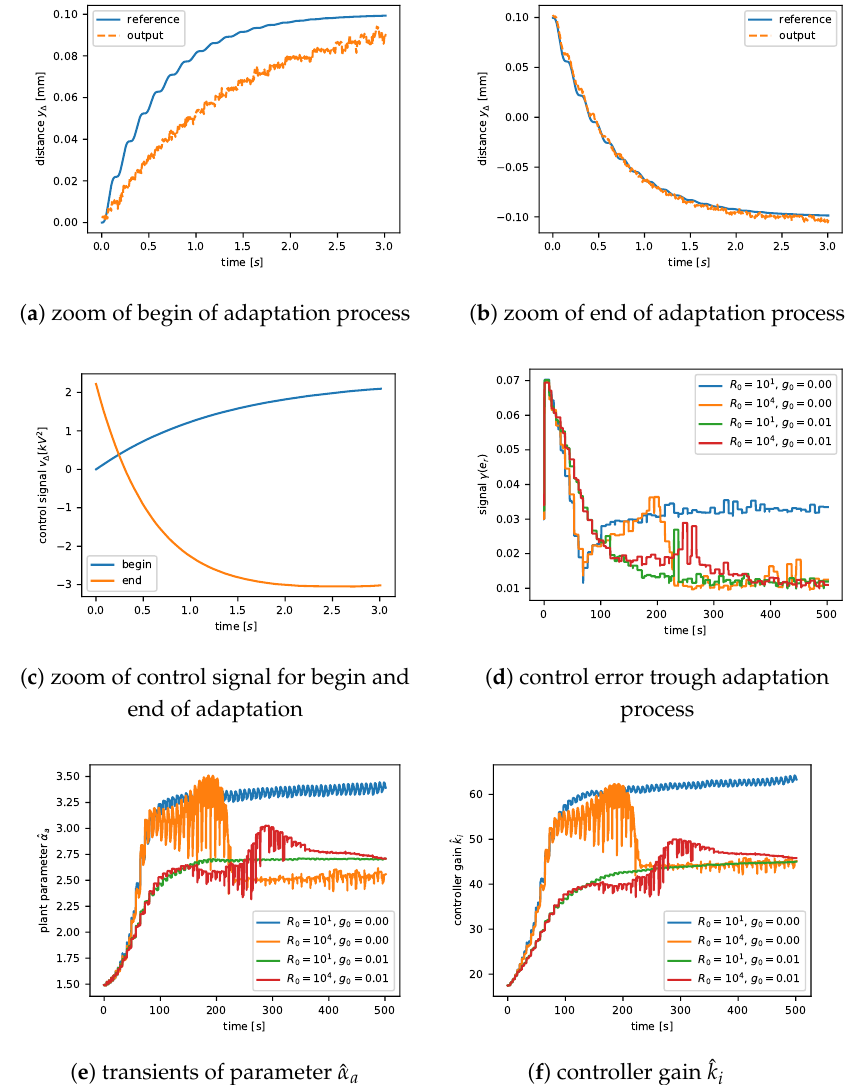
Figure 11. The transients of the adaptive control